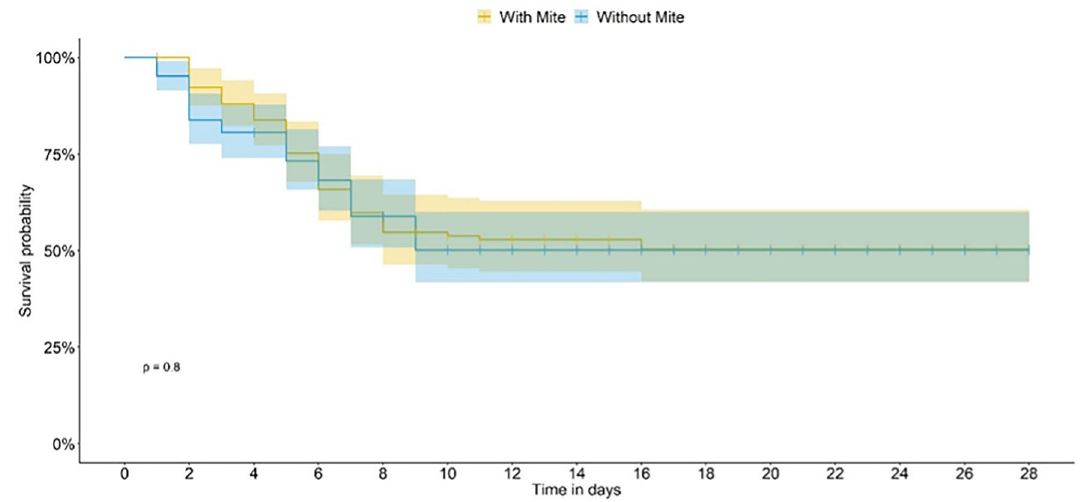
Figure 4. Scaptotrigona postica survivorship in the presence (with mites) and in the absence (without mites) in the dimethoate bioassay (DIM). PUPA POSTEMBRYONAL IMMATURE